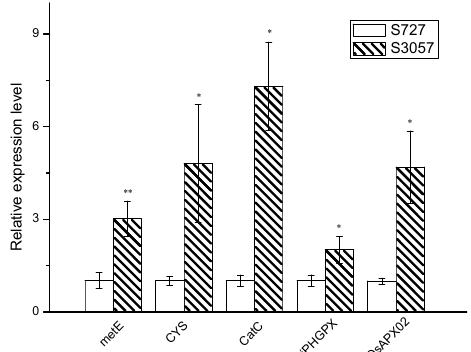
Figure 8. Relative abundance of selected DEPs revealed by realtime (qPCR) analysis.